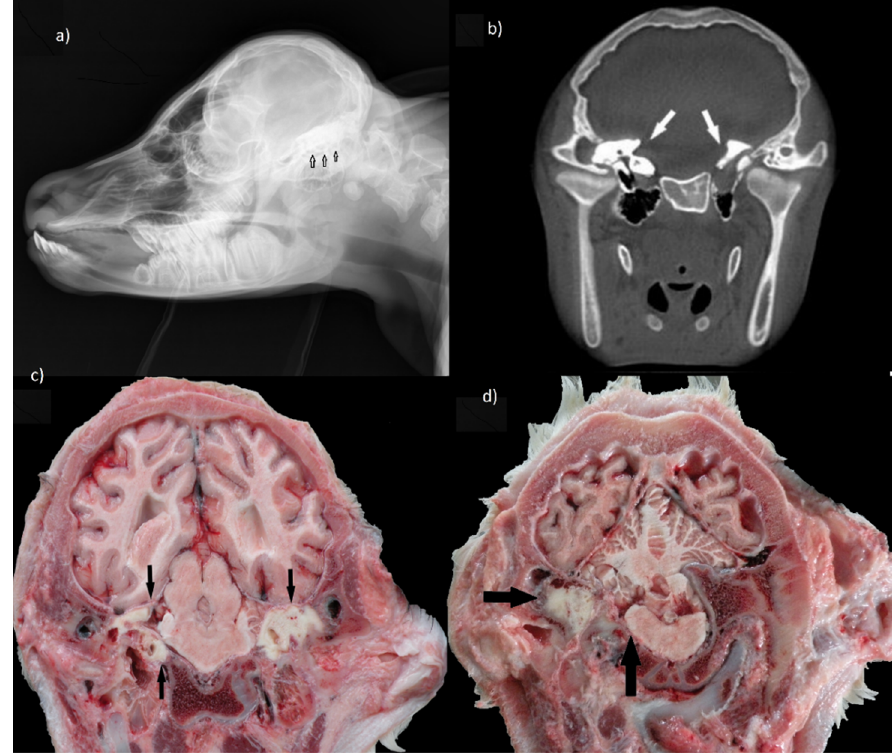
Figure 2. Ear teeth in the rtg picture and anatomical coronal sections; view towards caudal. ( a ) Rtg laterolateral view of the calf ’s head. Tooth-like structures are denser than bone. They are seen in the whole length of the temporal region (arrows). ( b ) The same view (arrows) in the TK coronar section of the temporal region. Asymmetry of the basilar part of the occipital bone and tympanic bulla is observed. ( c ) Coronal section on the level of basisphenoid bone and midbrain (mesencephalon). Dental tissues (arrows) are separated from cerebral hemispheres only by dura mater, without the mediation of osseous tissue. ( d ) Tooth germs (horizontal arrows) interfered with the petrous part of temporal bone. The abnormal osseous structure of this side of the neurocranium exerts pressure on the medulla oblongata causing its deformation (vertical arrow).